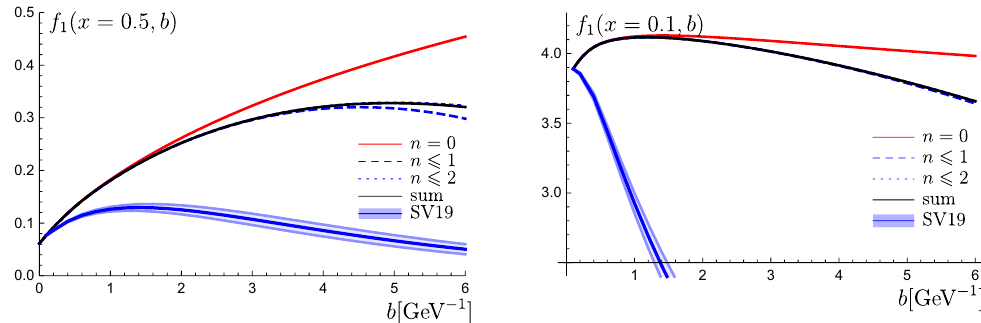
Figure 2 . Unpolarized TMD (for d-quark) as the function of b at different orders of mass correc- tions. The curve n = 0 corresponds to the leading term. The curves n 6 1 , 2 correspond to the partial sums (4.1) up to n = 1 , 2 . In all cases, the PDF is taken in the convolution with NNLO per- turbative coefficient function. The curve labeled as “sum” is the summed expression for target-mass corrections (4.13). The curve with a band is the extraction of non-perturbative TMD distribution f 1 made in ref.